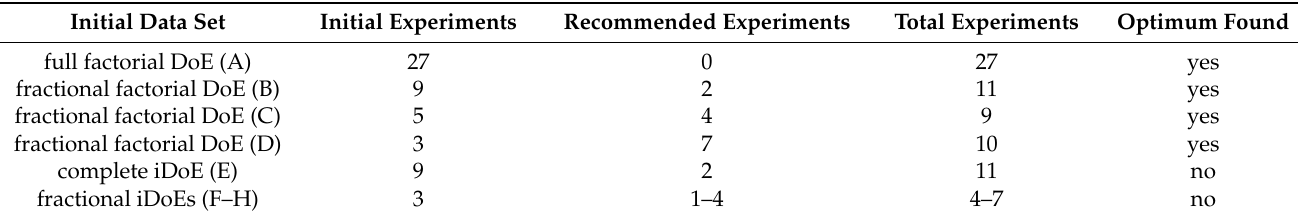
Table 2. Performance summary of the model-based DoE approaches. Capital letters in brackets represent the DoE conditions from Figure